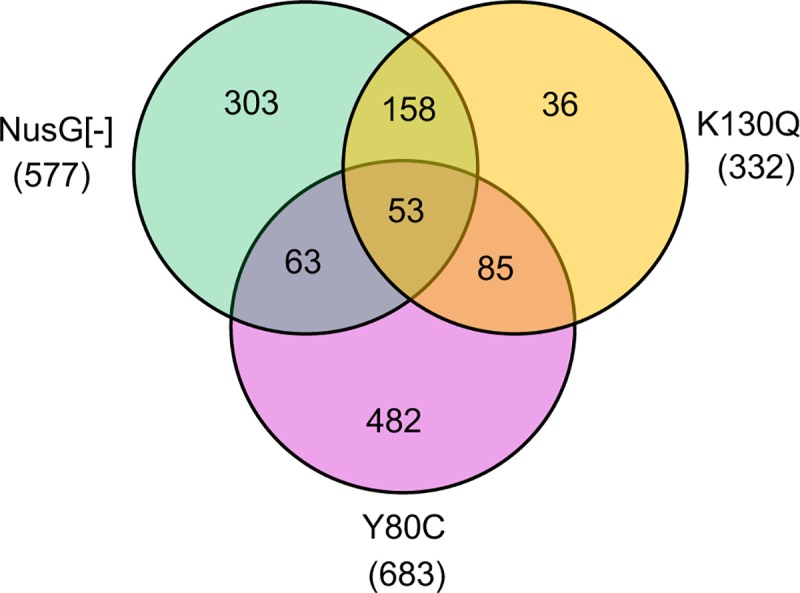
Venn diagram showing the distribution of genes affected by NusG depletion and/or Rho mutations.Only genes whose transcript levels increase 2-fold or more (log2FoldChange versus wt ≥ 1; padJ ≤ 0.05) under at least one of three conditions applied in this study (ARA treatment; Rho mutants Y80C and K130Q) were considered. Circle overlap areas denote genes responding to more than one condition. The gene names are listed in S2 Table. Note that for some genes, group assignment is critically dependent on the log2FoldChange and padJ cutoff values. For example, by setting log2FoldChange to ≥ 0.8 and padJ to ≤ 0.01, the number of genes responding to K130Q and not to the other conditions drops to 9.